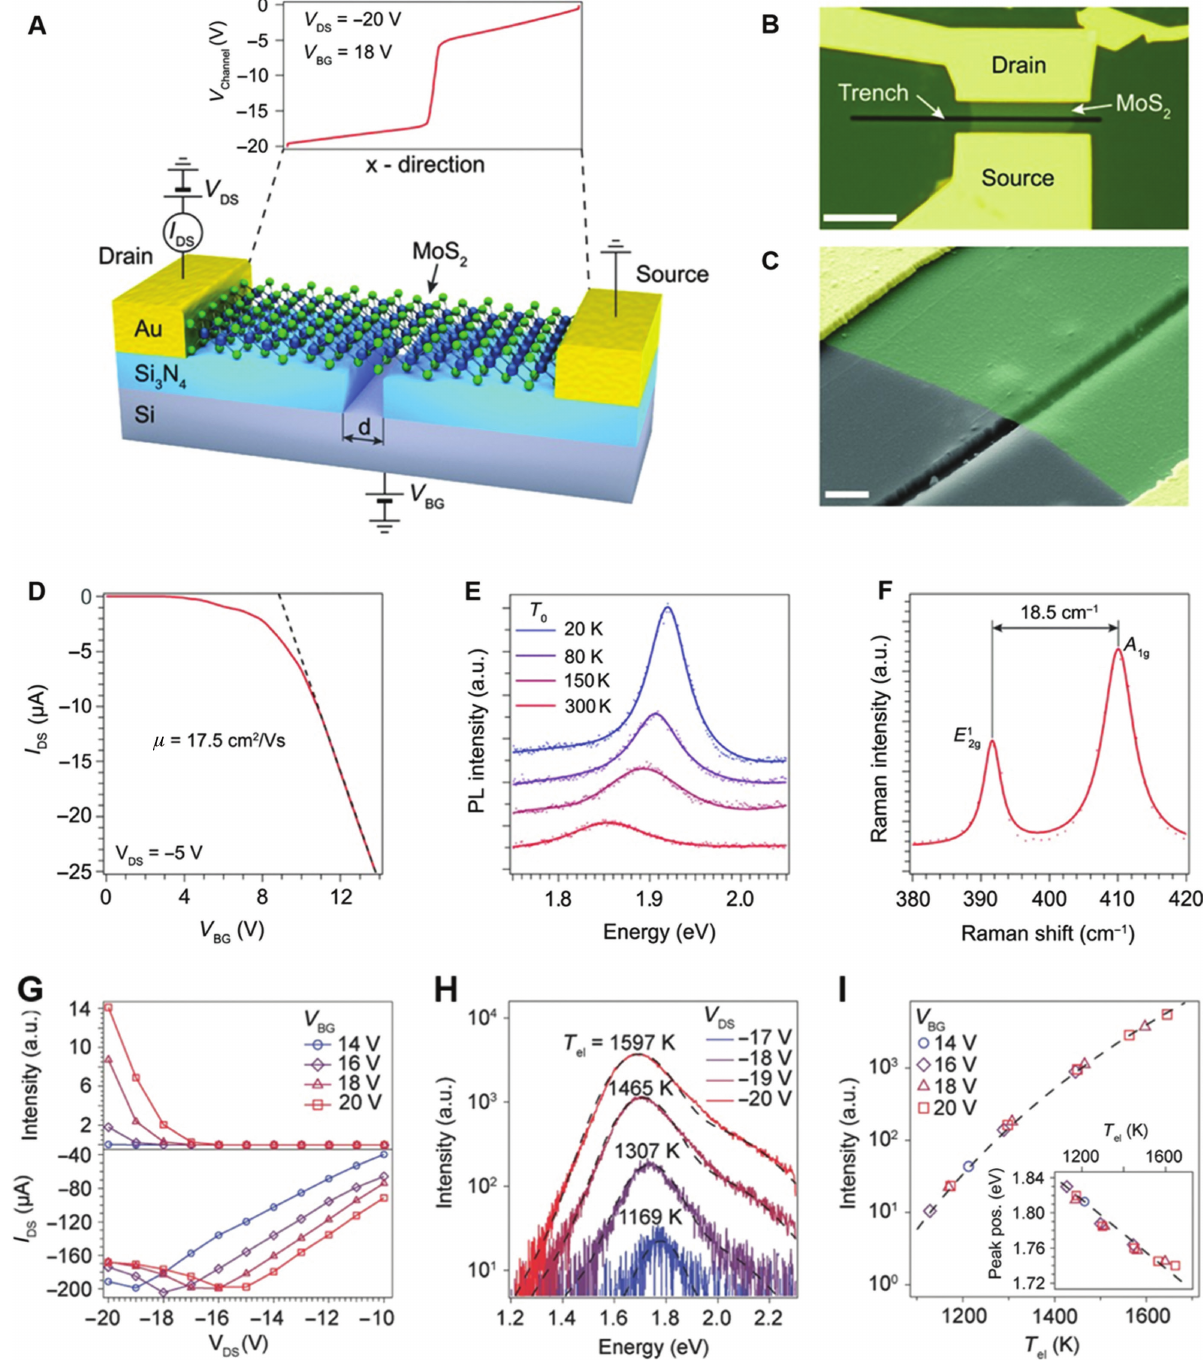
. Figure 3: Thermally excitonic emission in monolayer MoS 2 (A) Schematic diagram for the device structure with monolayer MoS suspended freely over a gap (width d ~ 150 nm). The monolayer MoS was 2 2 contacted with Ti/Au (2/60 nm) electrodes and separated from the Si substrate (backgate) via a 100-nm-thick dielectric (Si N ). The inset gives 3 4 = 18 V and V = –20 V. The small potential ( ~ 0.5 V) descends at x = 0 and x = L because of the calculated channel potential ( V ), when V Channel BG DS the contact resistance. (B) Optical and (C) scanning electron micrographs for a representative device. Scale bars in (B) are 10 μ m and in (C) are = –5 V and T = 80 K with W = 4.5 μ m and L = 4 μ m. (E) Offset PL emission from monolayer 400 nm. (D) Transfer characteristics measured at V DS 0 MoS at different temperatures, ranging from 20 K to 300 K. (F) Raman scattering spectrum of monolayer MoS . The frequency difference of 2 2 ~ 18.5 cm −1 between the 1 Raman modes verifies a thickness of one monolayer. (G) Integrated light emission intensity (upper plot) E and A 1g 2g and the corresponding current I (lower plot) vs. applied voltage of V for V ranging from 14 to 20 V. (H) Logarithmic scale thermal emission DS DS BG = 18 V and V spectra with V ranging from −17 to −20 V. The T was extracted via using the Planck’s law (dashed line). (I) Thermal emission BG DS el intensity vs. T , plotted with logarithmic scale. Inset: the shift of the A-exciton peak with respect to T . Reprinted with permission of Ref. el el